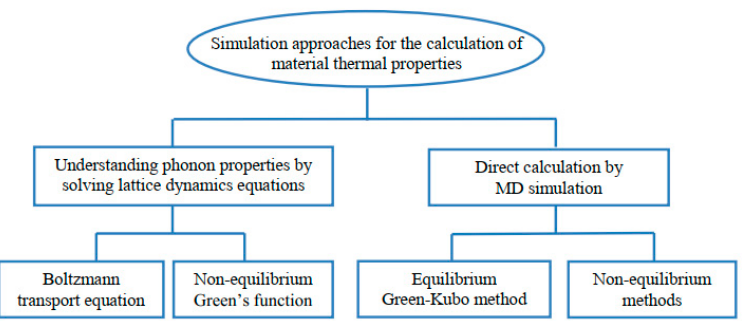
Figure 4. Materials thermal property classifications based on atomistic simulations [45]. Reprinted with permission from ref. [45]. Taylor & Francis Group LLC – Books.